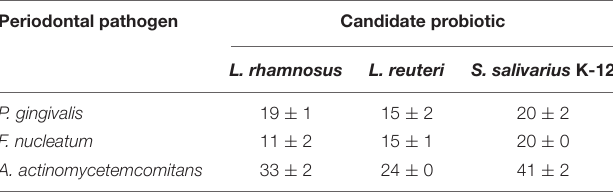
TABLE 1 | Inhibition of periodontal pathogens by suspensions of candidate probiotics.